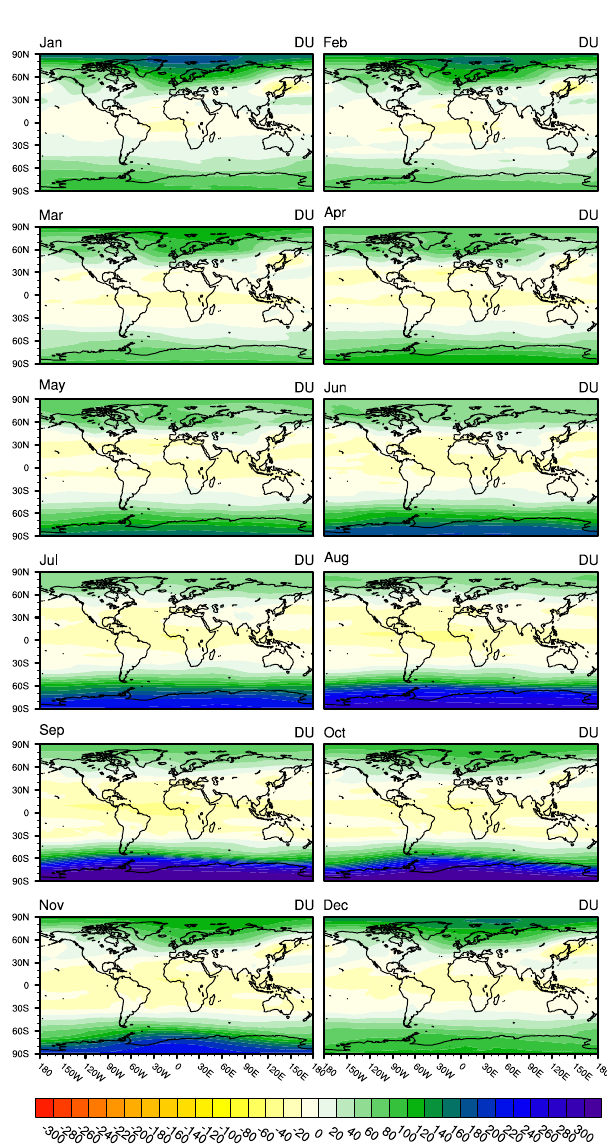
Figure 7. Bias in the total ozone column using the MSR monthly averages for the period (1979–2008) as a baseline for